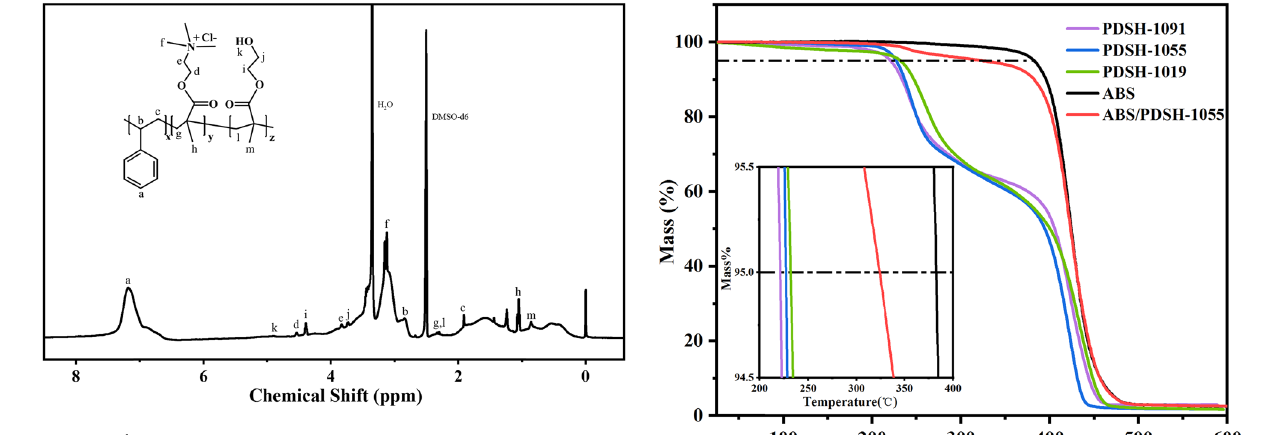
Figure 2: 1 H NMR spectra of PDSH - 1055 in DMSO - d 6 .